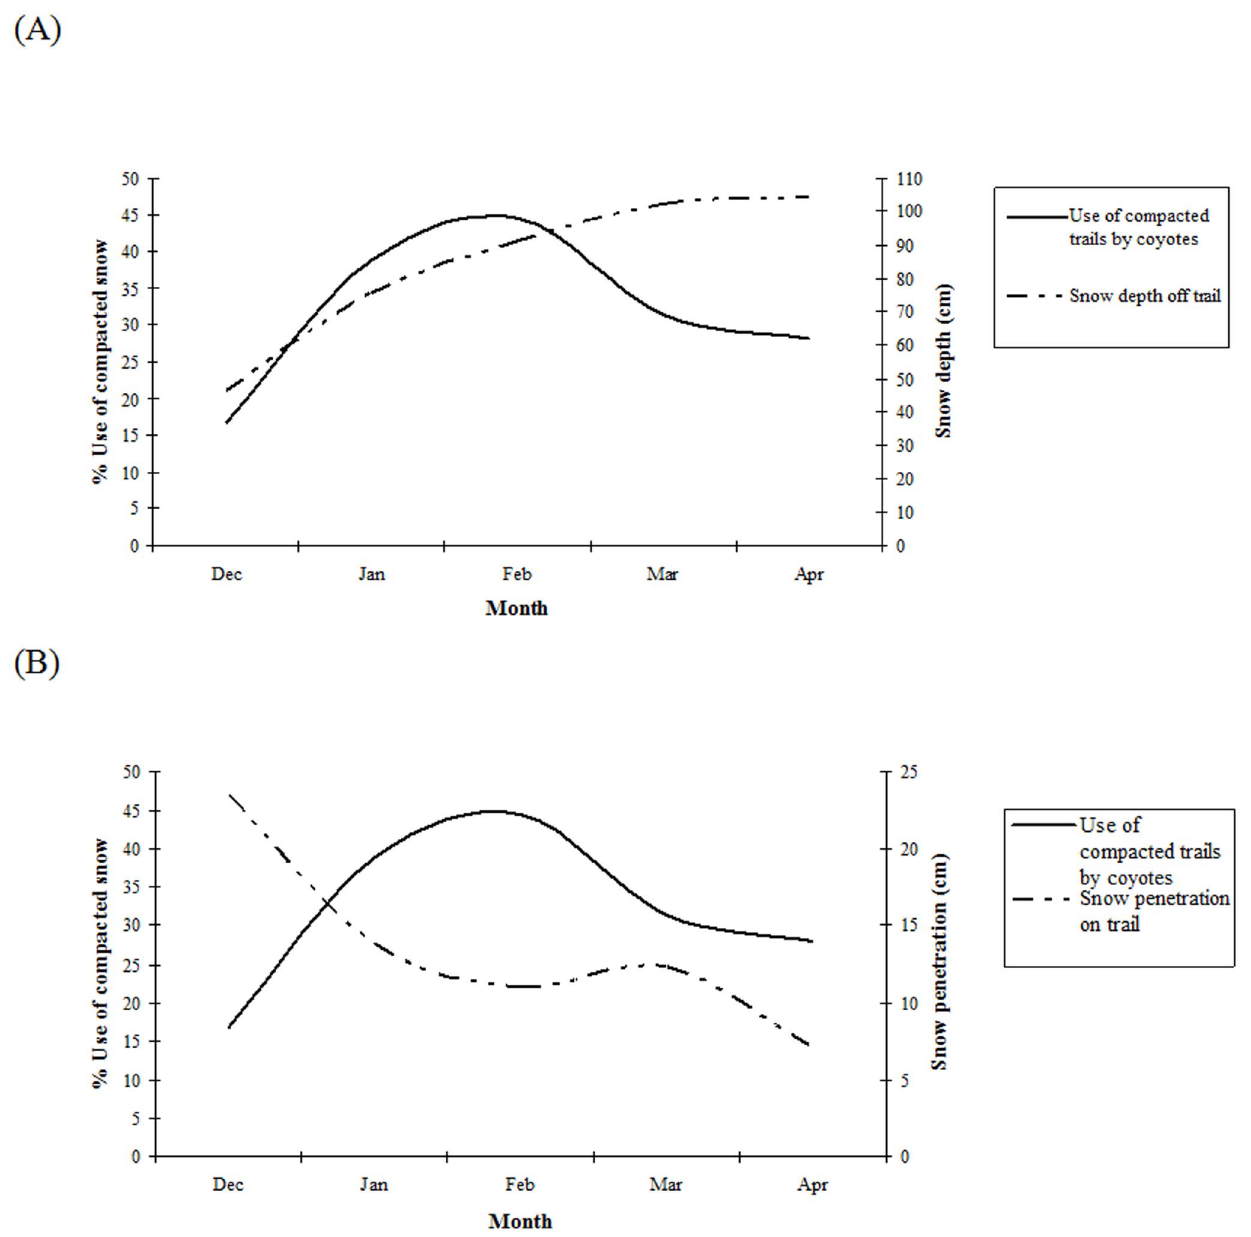
Figure 2. Percent use of snowmobile trails by coyotes in relation to (A) snow depth off the snowmobile trail, and (B) snow penetrability on the snowmobile trail, for each winter month, December 2007 through April 2008, northwestern